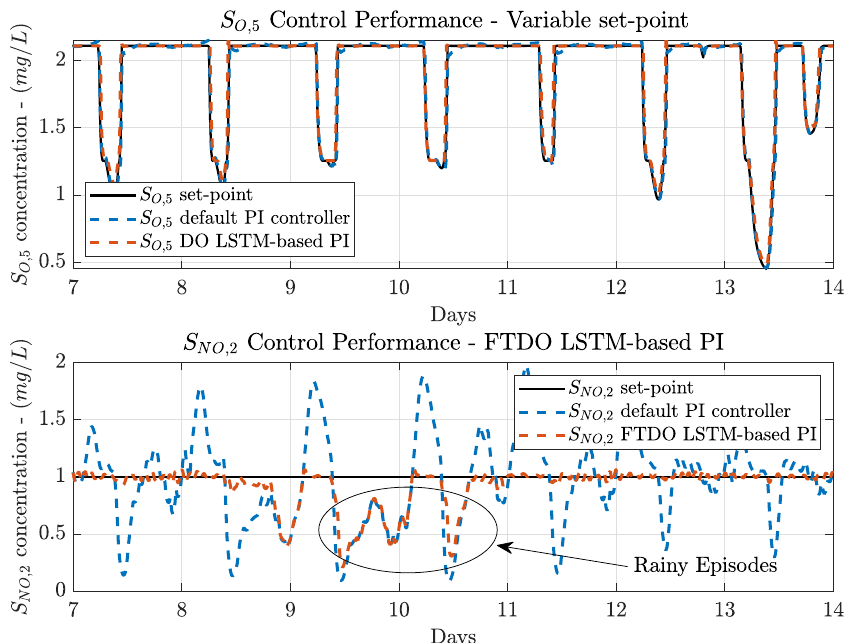
Figure 10. Control performance for the NO and DO control loops when a S O ,5 variable set-point and rainy weathers are considered. The LSTM-based PI managing the NO loop is transferred from the DO control loop and fined-tuned with data from the NO control